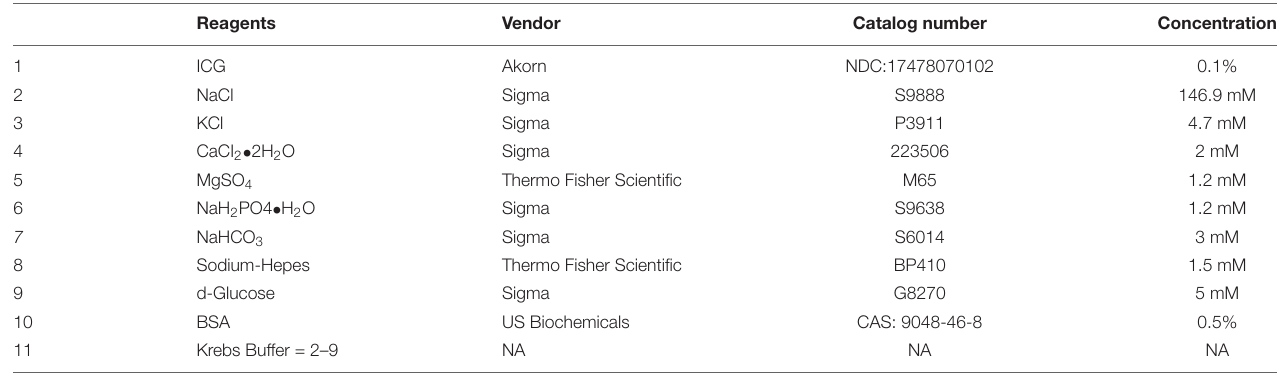
TABLE 1 | Key experimental